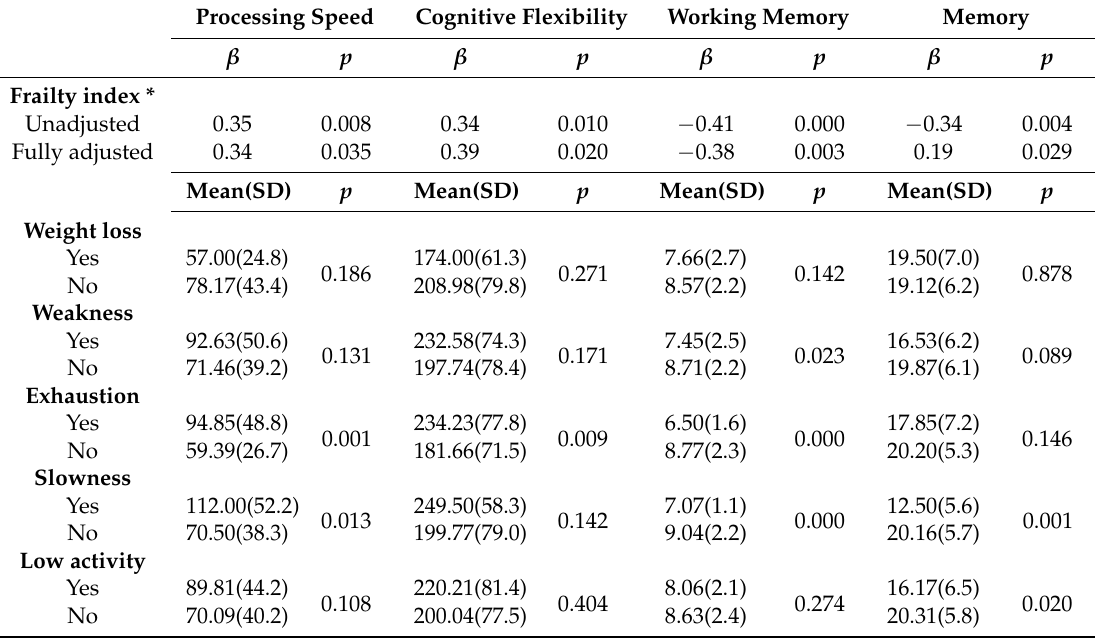
Table 2. Association between presence of each criterion of the frailty index and different measures of cognitive function (fully adjusted).